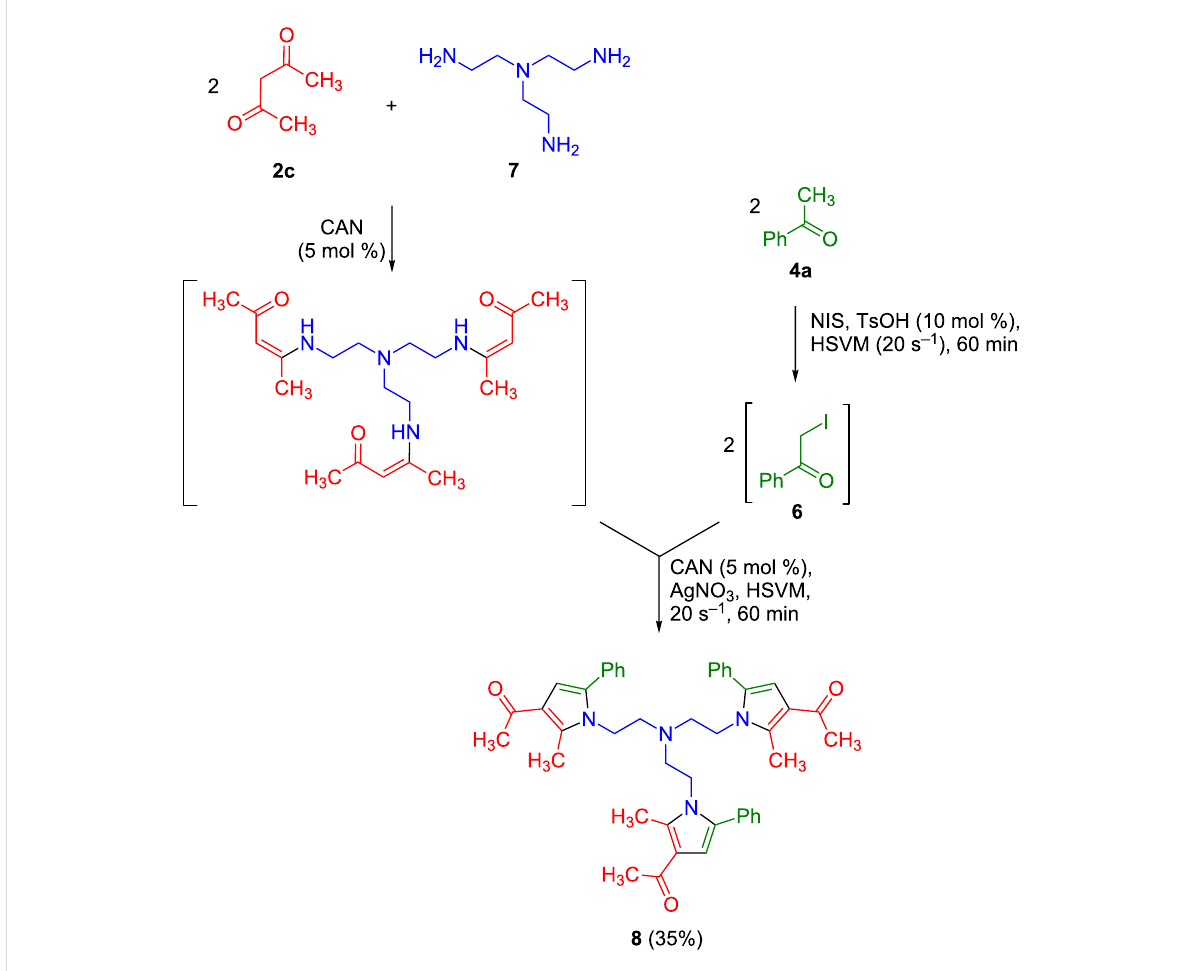
Scheme 3: A pseudo-seven-component reaction that affords a terpyrrole derivative with a functionalized spacer.